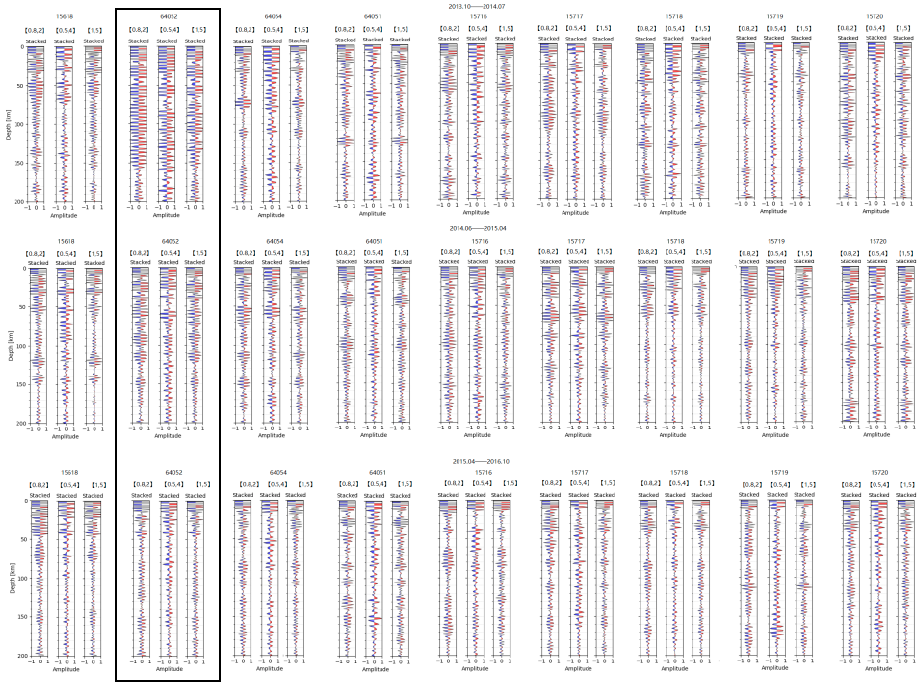
Figure 12. L6 (from left to right: 15618, 64052, 64054, 64051, 15716, 15717, 15718, 15719 and 15720) reflects the depth results of different frequency bands from October 2012 to July 2014, June 2014 to April 2015 and April 2015 to October 2016, respectively.